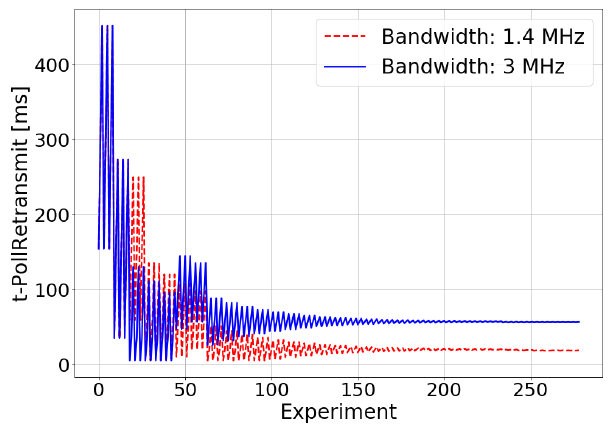
Figure 7. Simulated scenario—t-PollRetrasmit adjustment.